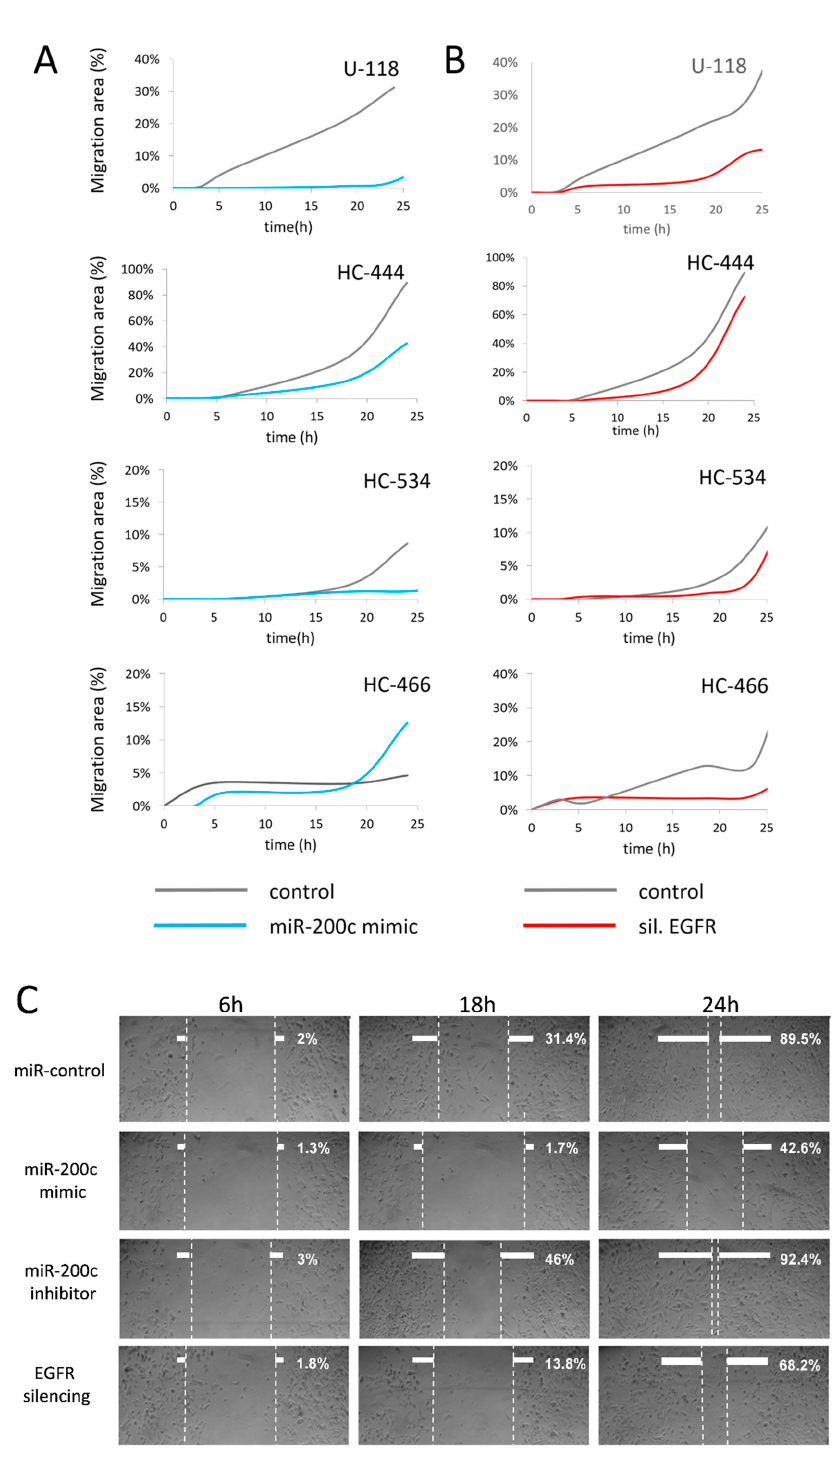
Figure 6. Cell migration assays. ( A ) Effect of miR-200c mimic transfection on cell migration in the four cultures at different times. ( B ) Effect of EGFR siRNAi transfection on cell migration in the four cultures at different times. ( C ) Wound healing assay in HC-444 cells. The wound healing assay was conducted 6, 18 and 24 h after transfection in: control cells, cells overexpressing miR-200c, cells with miR-200c inhibition and cells with silenced EGFR. Pictures show the results in HC-444 culture. All the experiments were performed three times. Graphs and micrographs show one representative experiment from